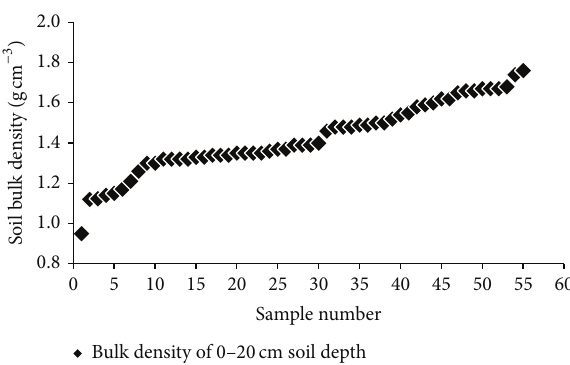
Figure 1: Variation in soil bulk density of paddy-upland rotations. Data are from [2, 13, 14,